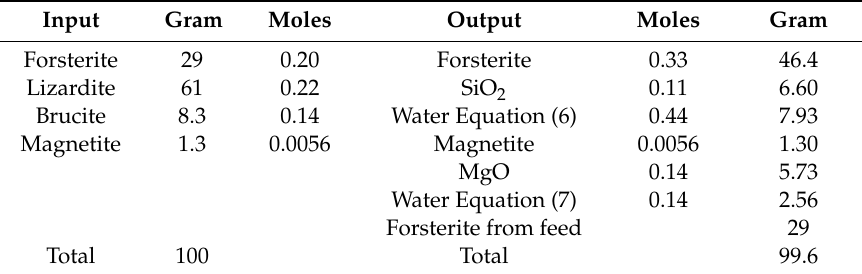
Table 1. Mass balance to calculate theoretical forsterite.